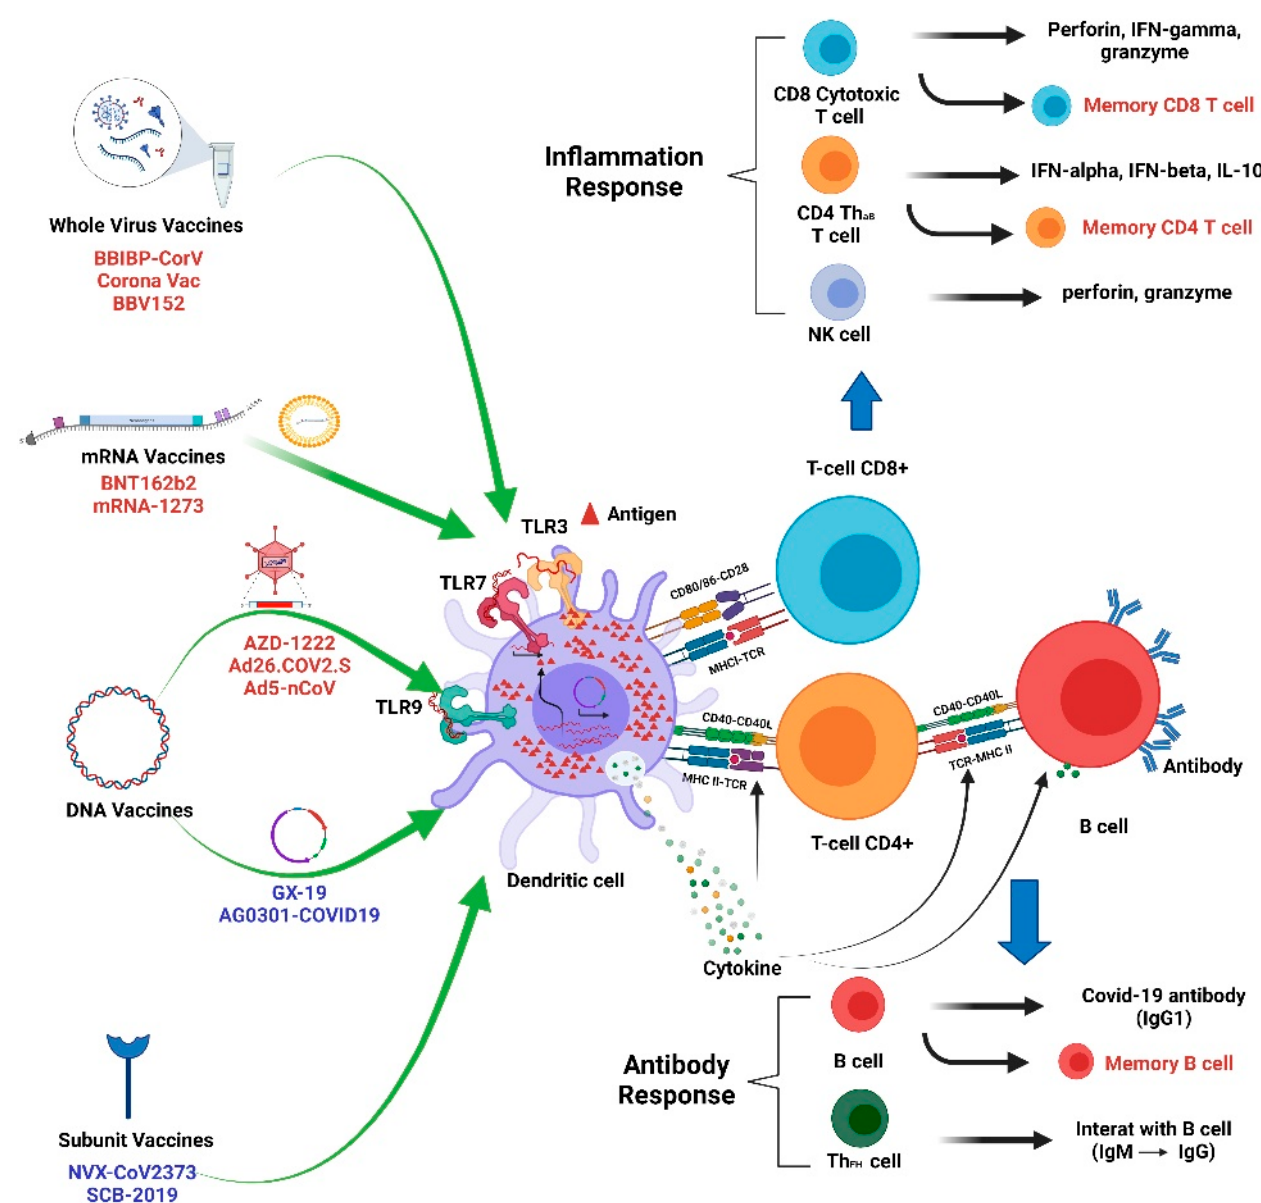
Figure 3. Immunogenicity of COVID-19 vaccines.